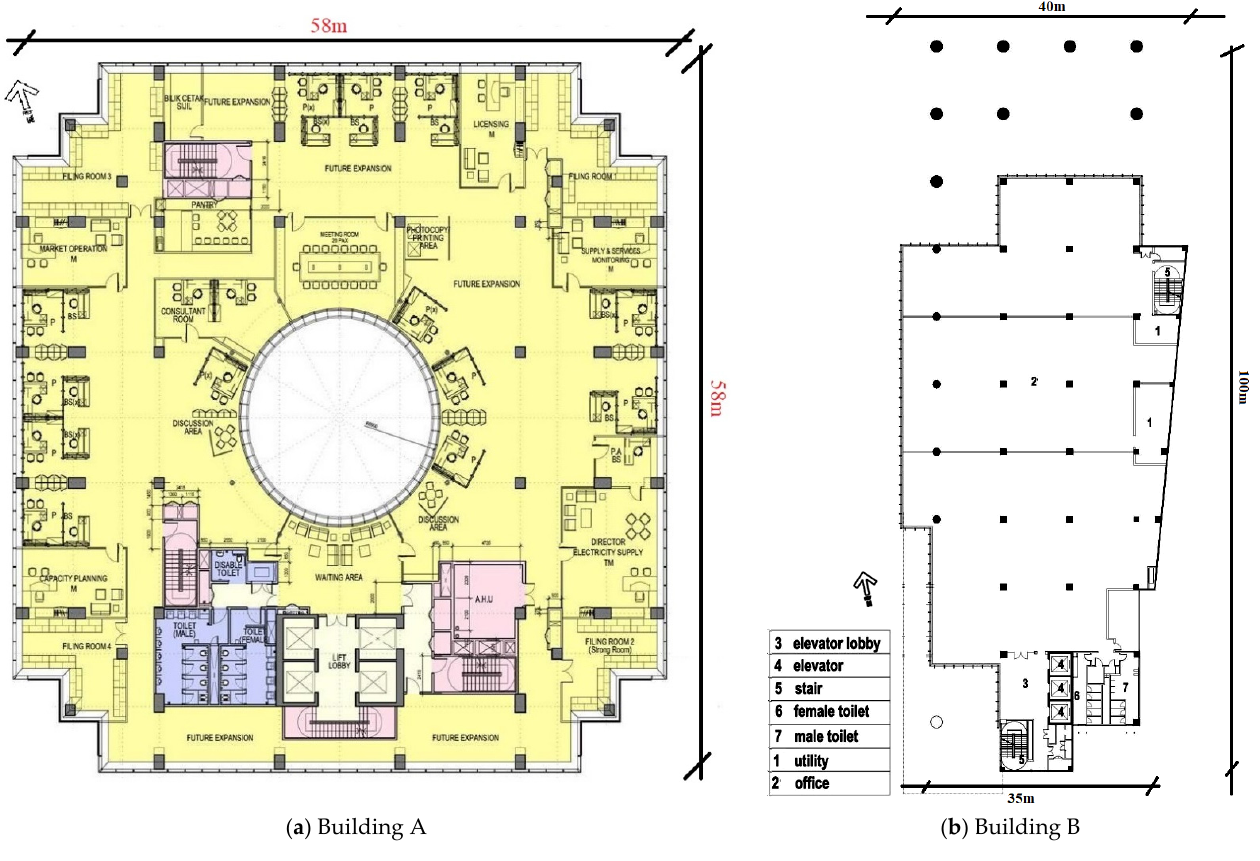
Figure 1. Plan layout of buildings.